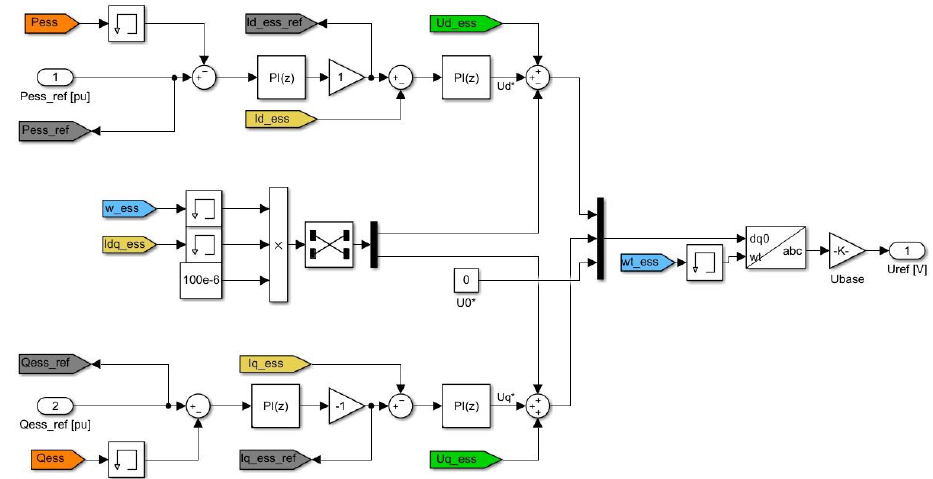
Figure 5. VSC low-level control model in MATLAB